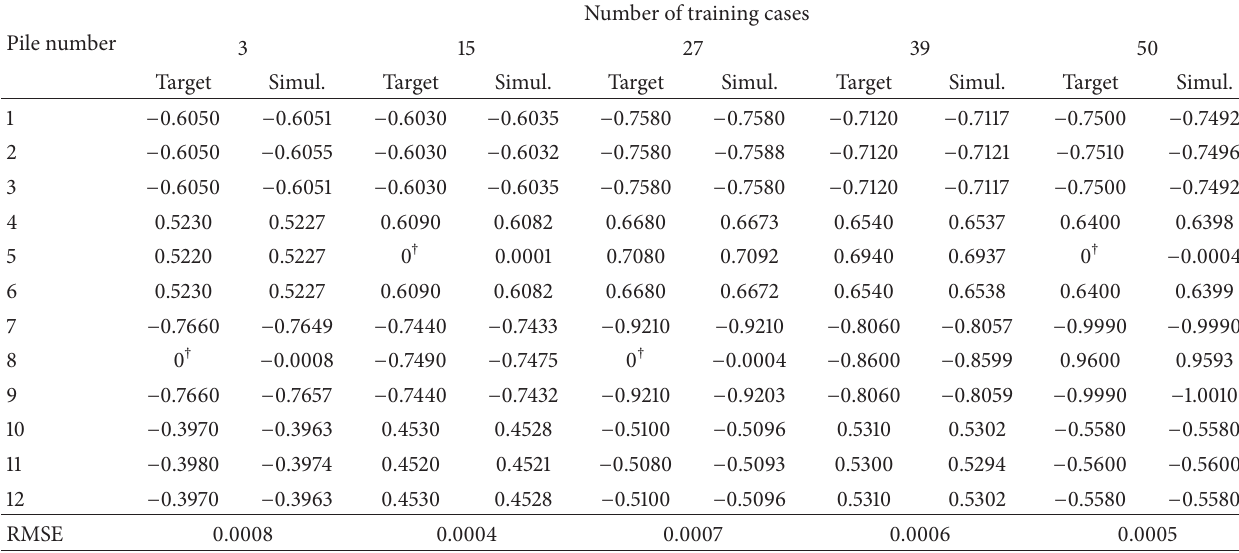
Table 8: Simulation